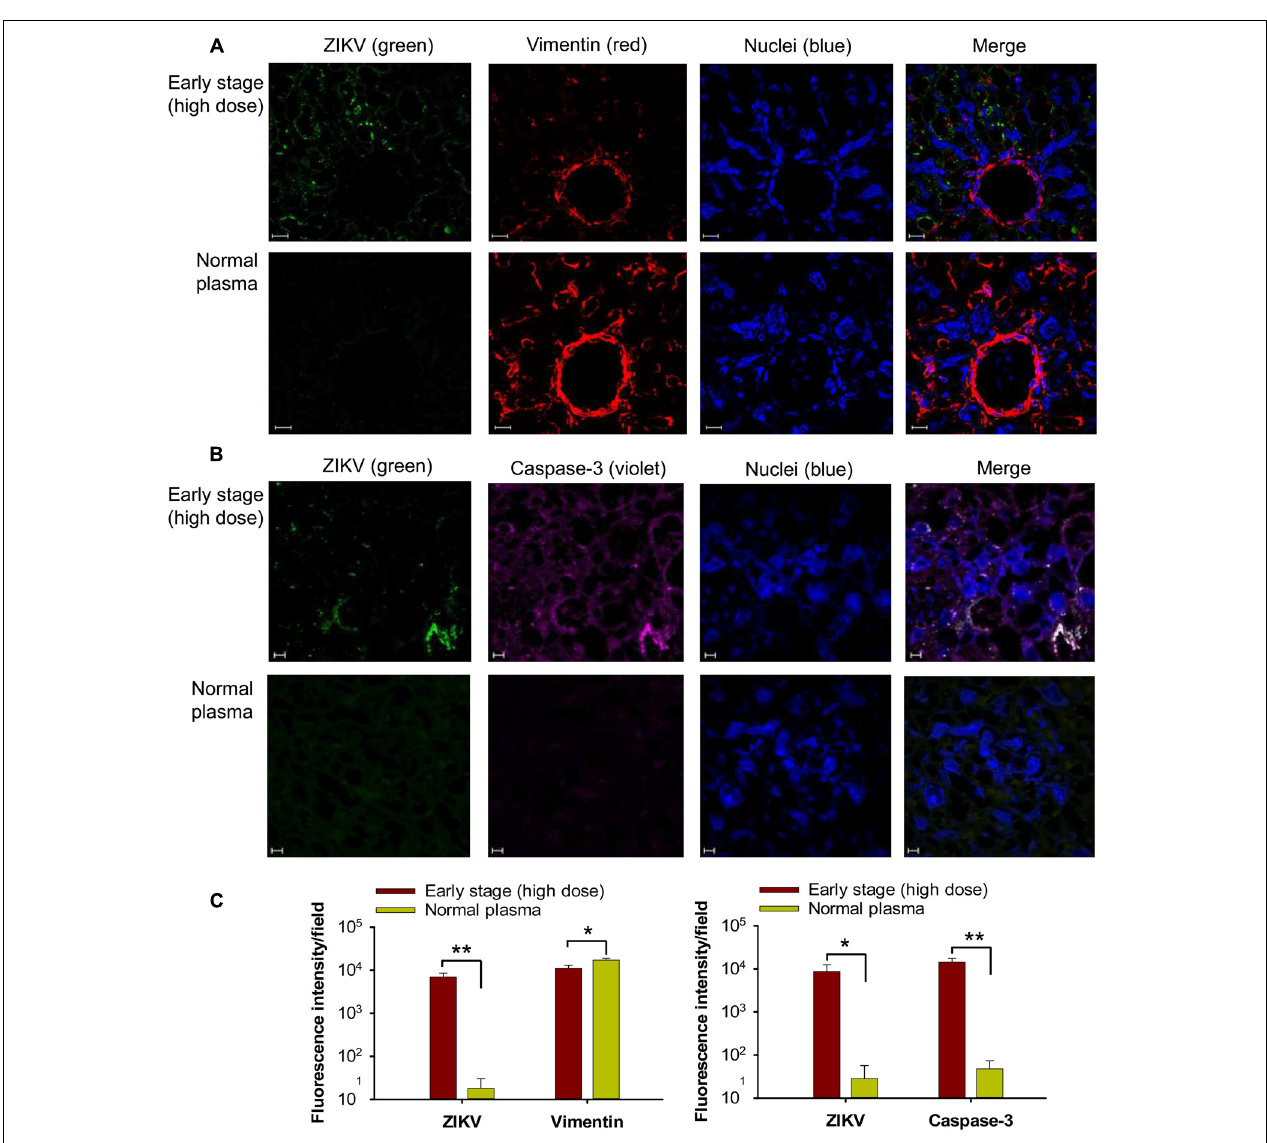
FIGURE 5 | Transfusion of pregnant A129 mice with early-stage (high dose) ZIKV + plasma caused vascular damage and apoptosis in placentas. Placentas were collected from pregnant (E10–12) A129 mice transfused with early-stage (high dose) ZIKV + plasma 6 days after transfusion, and used for below tests. Representative images of immunofluorescence staining of vimentin (A) and activated form of caspase-3 (B) in placentas are shown. ZIKV (green), vimentin (red), and activated caspase-3 (violet) were stained with anti-ZIKV, anti-vimentin, and anti-active caspase-3 antibodies, respectively. Nuclei were stained with DAPI, and are shown in blue. Magnification: 63X. Scale bar: 10 µ m. (C) Quantification of vimentin and caspase-3 staining in (A) and (B) by ImageJ software as described above. The data are presented as mean fluorescence intensity for ZIKV + , vimentin + , or caspase-3 + staining in each field ± s.e.m ( n = 6, “ n ” indicates numbers of image from different placentas). ∗ and ∗∗ indicate significant differences between early stage (high dose) and normal plasma groups. Normal plasma: control plasma from A129 mice transfused with normal plasma without ZIKV.